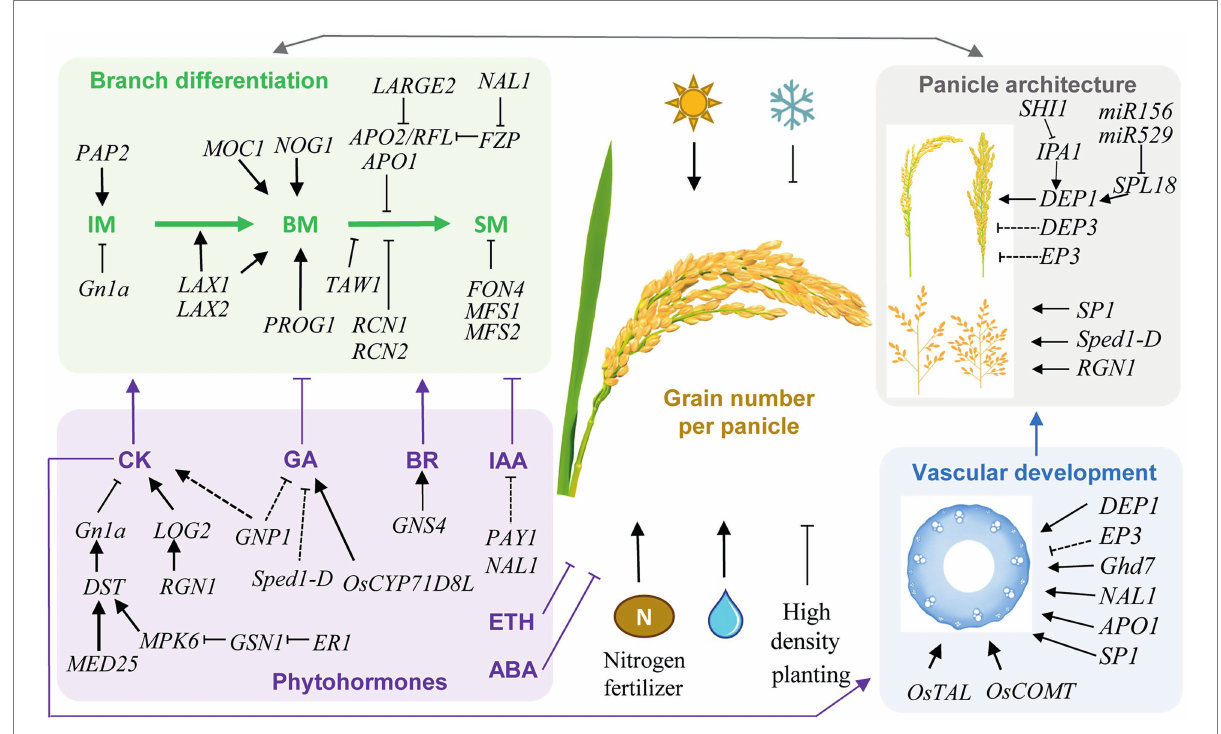
FIGURE 1 Schematic representation of genetic and environmental factors controlling grain number per panicle (GN) in rice. Key genes and regulatory pathways in controlling GN are indicated. Arrows indicate positive regulation, while T lines indicate negative regulation. Dashed lines indicate indirect regulations. Rice GN is determined by the panicle architecture and branch differentiation, which are associated with phytohormones and vascular development. These regulatory pathways are interconnected in regulating GN. In the determination of panicle architecture, the DEP1 , DEP3 , and EP3 genes control the dense and erect panicle type, while SP1 , Sped1-D , and RGN1 regulate panicle length and branch number. Transcription factors IPA1 and SPL18 positively regulates the expression of DEP1 . SHI1 interacts with IPA1 and inhibit its activity, while microRNAs miR156 and miR529 regulate the expression level of SPL18 . The branch differentiation involves the activity and phase transition of inflorescence meristem (IM), branch meristem (BM), and spikelet meristem (SM). Increasing the meristem activity and delaying the transition from BM to SM have a positive effect on GN. Phytohormones were also crucial regulators of GN through manipulating branch differentiation, among which cytokinin (CK) and brassinosteroid (BR) are positive regulators, while indole 3-acetic acid (IAA), gibberellin (GA), abscisic acid (ABA), and ethylene (ETH) are negative regulators. The key GN regulator GN1a encodes a CKX, which negatively regulate CK level, and is regulated by the ER1 - GSN1 - MPK6 - DST signal cascade, while MED25 functions as a coactivator with DST to promote expression of GN1a . Vascular development is closely associated with GN through affecting the panicle architecture and translocation capability for water and nutrients. Many GN-associated genes also function in regulating vascular development, while the key vascular development regulators OsTAL and OsCOMT both have significant positive effects on